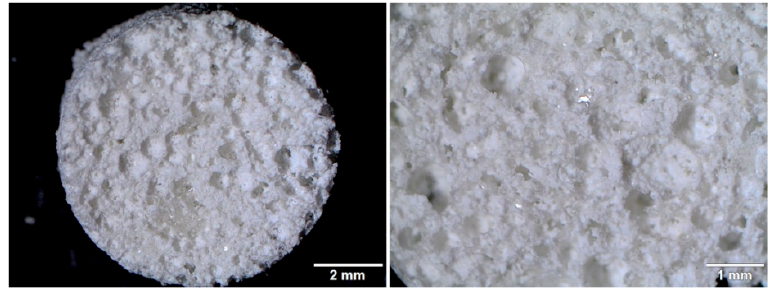
Figure 3. Microstructure of the chitosan-agarose-HA (chit/aga/HA) scaffold visualized by a stereoscopic microscope.